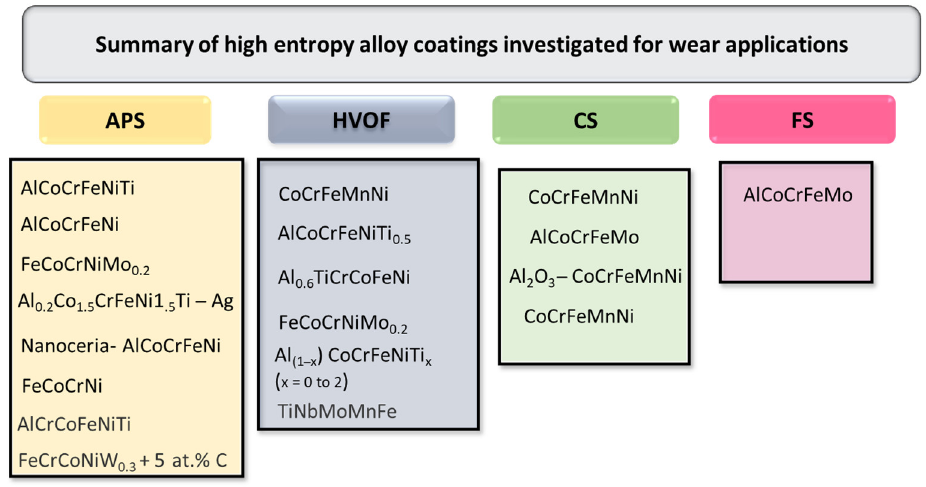
Figure 11. Summary of different thermal-sprayed HEA coatings investigated for wear behavior.